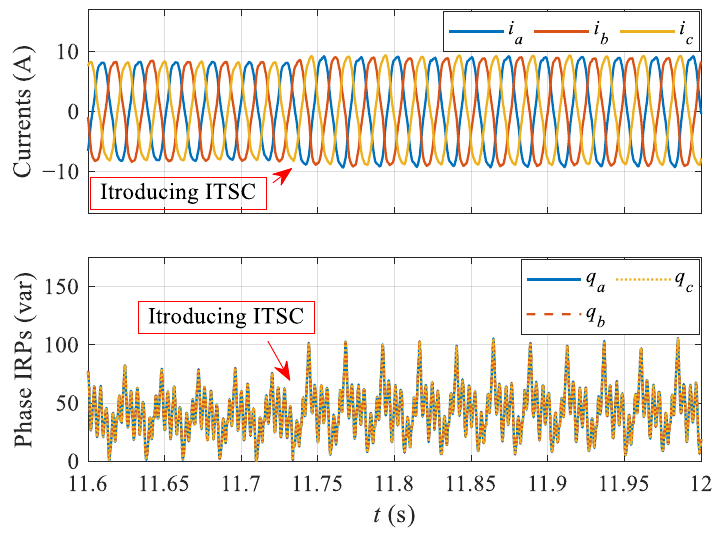
Figure 10. The phase currents and circulating current ( top ), the neutral current ( middle ) and the phase IRPs ( bottom ) before and after ITSC. Operating conditions: machine speed ω m = 500 r/min and load torque T L = 10 N∙m. Fault severity: Δ = 0. 1, r f = 0.2 Ω .